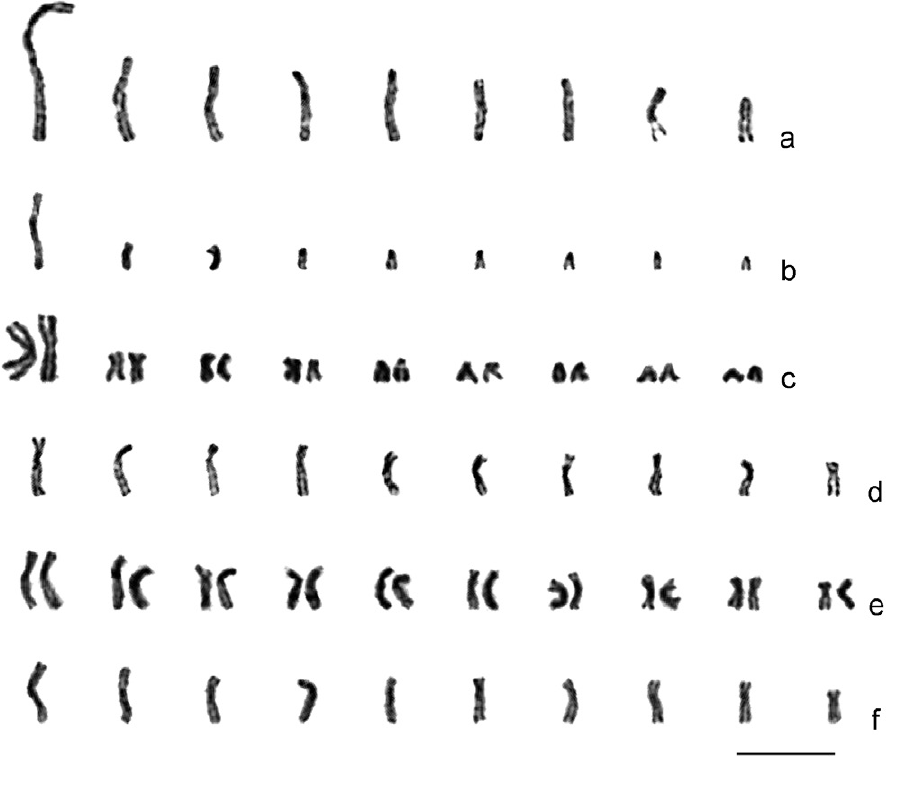
Figure 2. Karyograms of Drosophila parasitoids. a Ganaspis xanthopoda , haploid set b Leptopilina bou- lardi (strain 17), haploid set c ditto, diploid set d L. heterotoma (New York strain), haploid set e ditto, diploid set f L. victoriae , haploid set. Scale bar 10